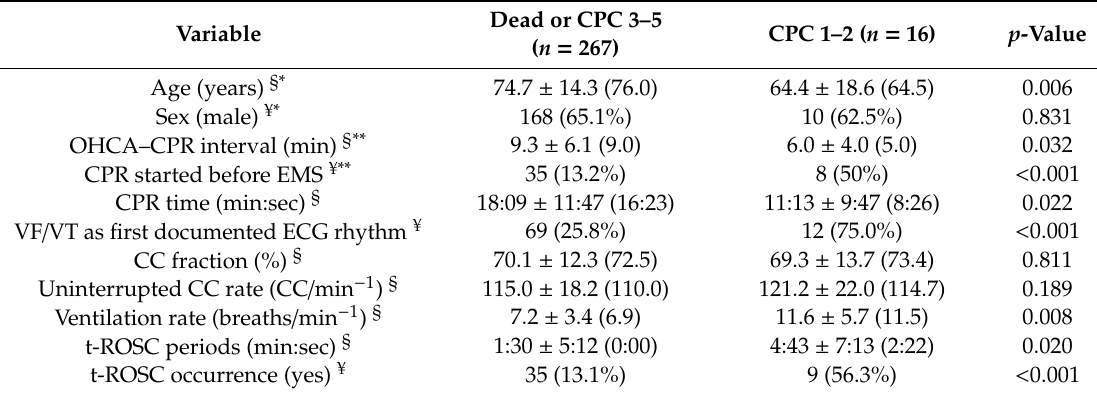
Table 4. Relationships of CA-related variables with outcome at hospital discharge.